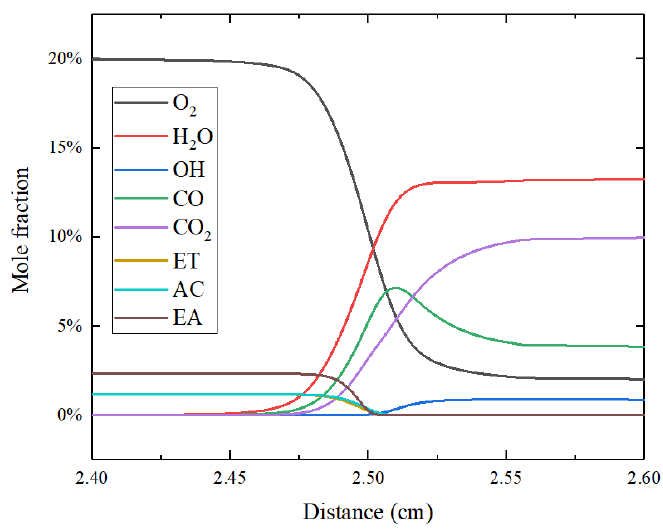
Figure 8. Flame structure of ETEAAC 121 determined with the skeletal mechanism at ϕ = 1.0.